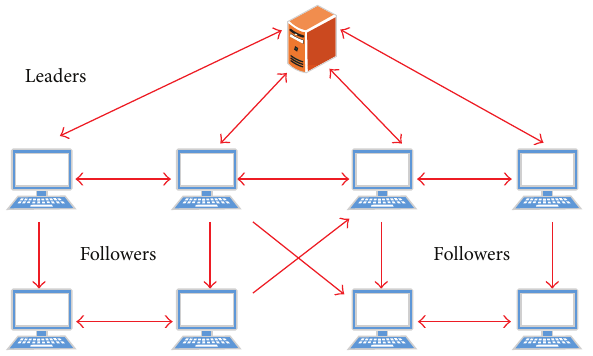
Figure 3: Pinning control structure of multiagent